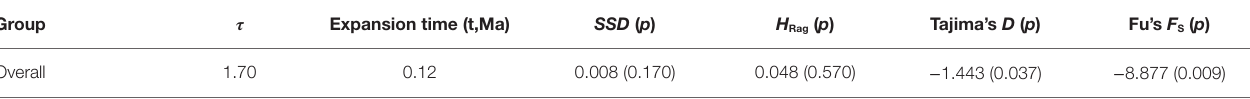
TABLE 3 | Results of neutrality tests and mismatch distribution analysis for Lycium ruthenicum populations.